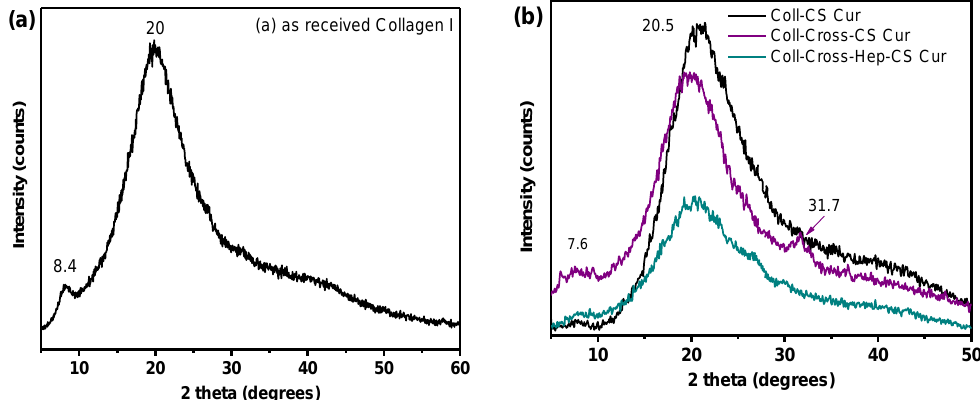
Figure 6. XRD patterns of ( a ) as-received collagen type I and ( b ) collagen patches with CS-Cur NPs.